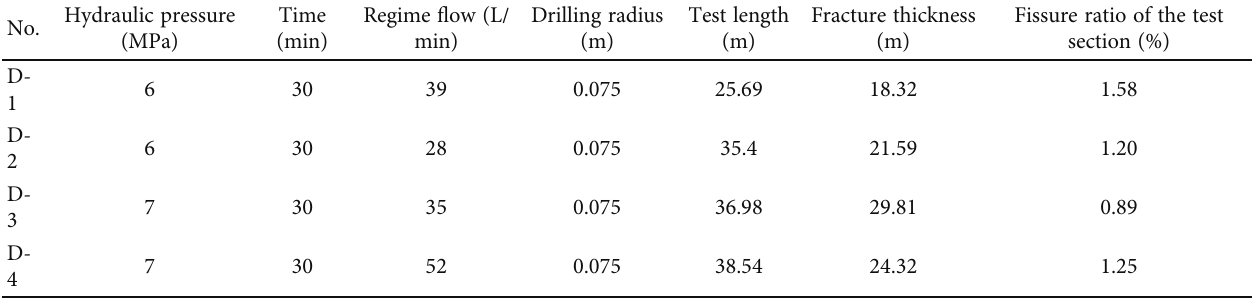
Table 5: Data of PPT and core drilling.